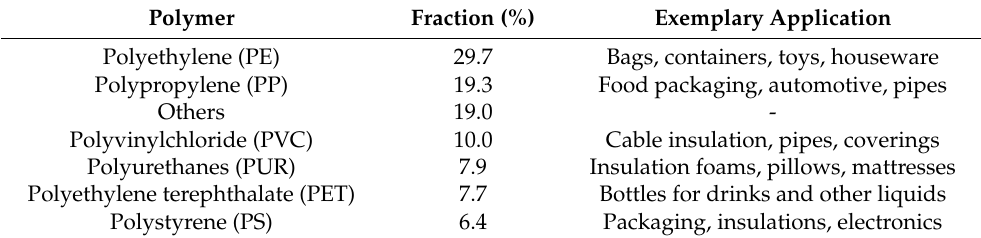
Table 2. European polymer demand by chemical structure in 2018 [1].